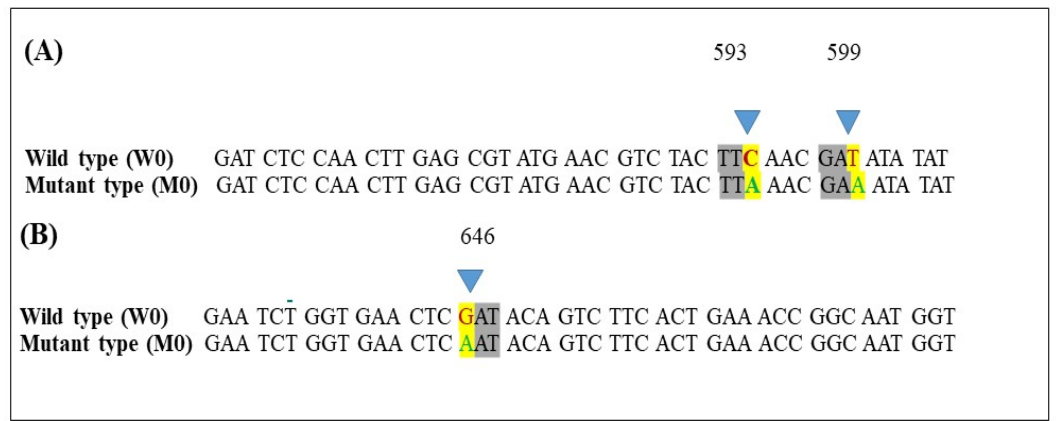
Figure 8. Amino acid sequence alignment of B. cinerea tubulin genes in wild type (W0) and its mutant (M0), ( A ): Mutation variation in bctubA gene at position 593 and 599, ( B ): Mutation variation in bctubB gene at position 646.